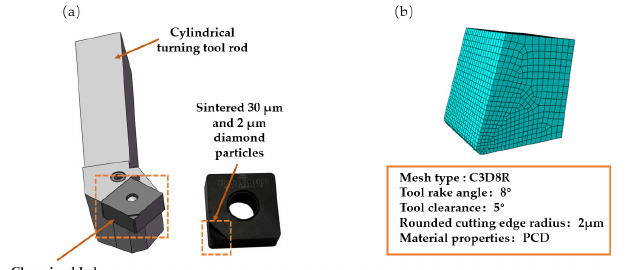
Figure 5. PCD tool schematic: ( a ) structure diagram of PCD tool and ( b ) PCD tool simulation model.